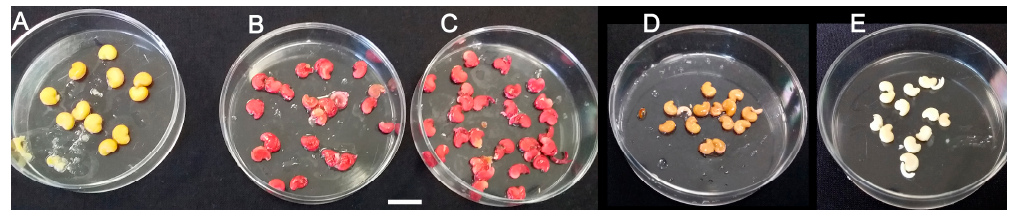
Figure 2. Testing viability of wild M. autumnalis seeds based on the tetrazolium (TZ) assay. ( A ) intact seeds remained unstained due to seed coat permeability resistance as proven with the downstream 1% methylene blue permeability assay (Figure 3); ( B ) seeds stored for 2.5 or ( C ) 3.5 years showed almost 100% viability as endosperms of decoated seeds turned red after staining treatments; ( D ) negative controls of heat-killed decoated seeds incubated for 1 h at 100 °C before TZ treatment remained unstained; ( E ) negative controls of non-treated decoated seeds. Scale size bar = 1 cm.